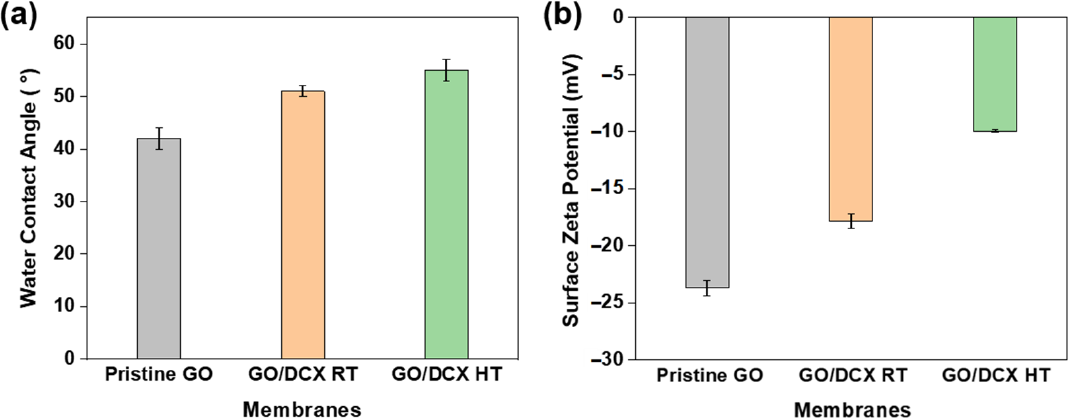
Figure 6. The ( a ) water contact angle and the ( b ) surface zeta potential of the prepared mem- branes.